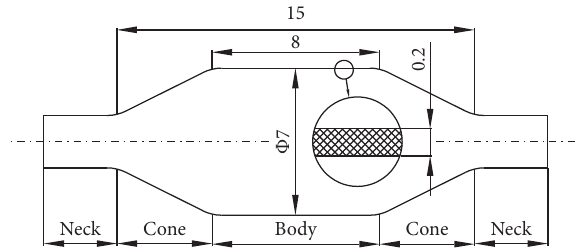
Figure 1: Structure and size of kyphoplasty balloon.